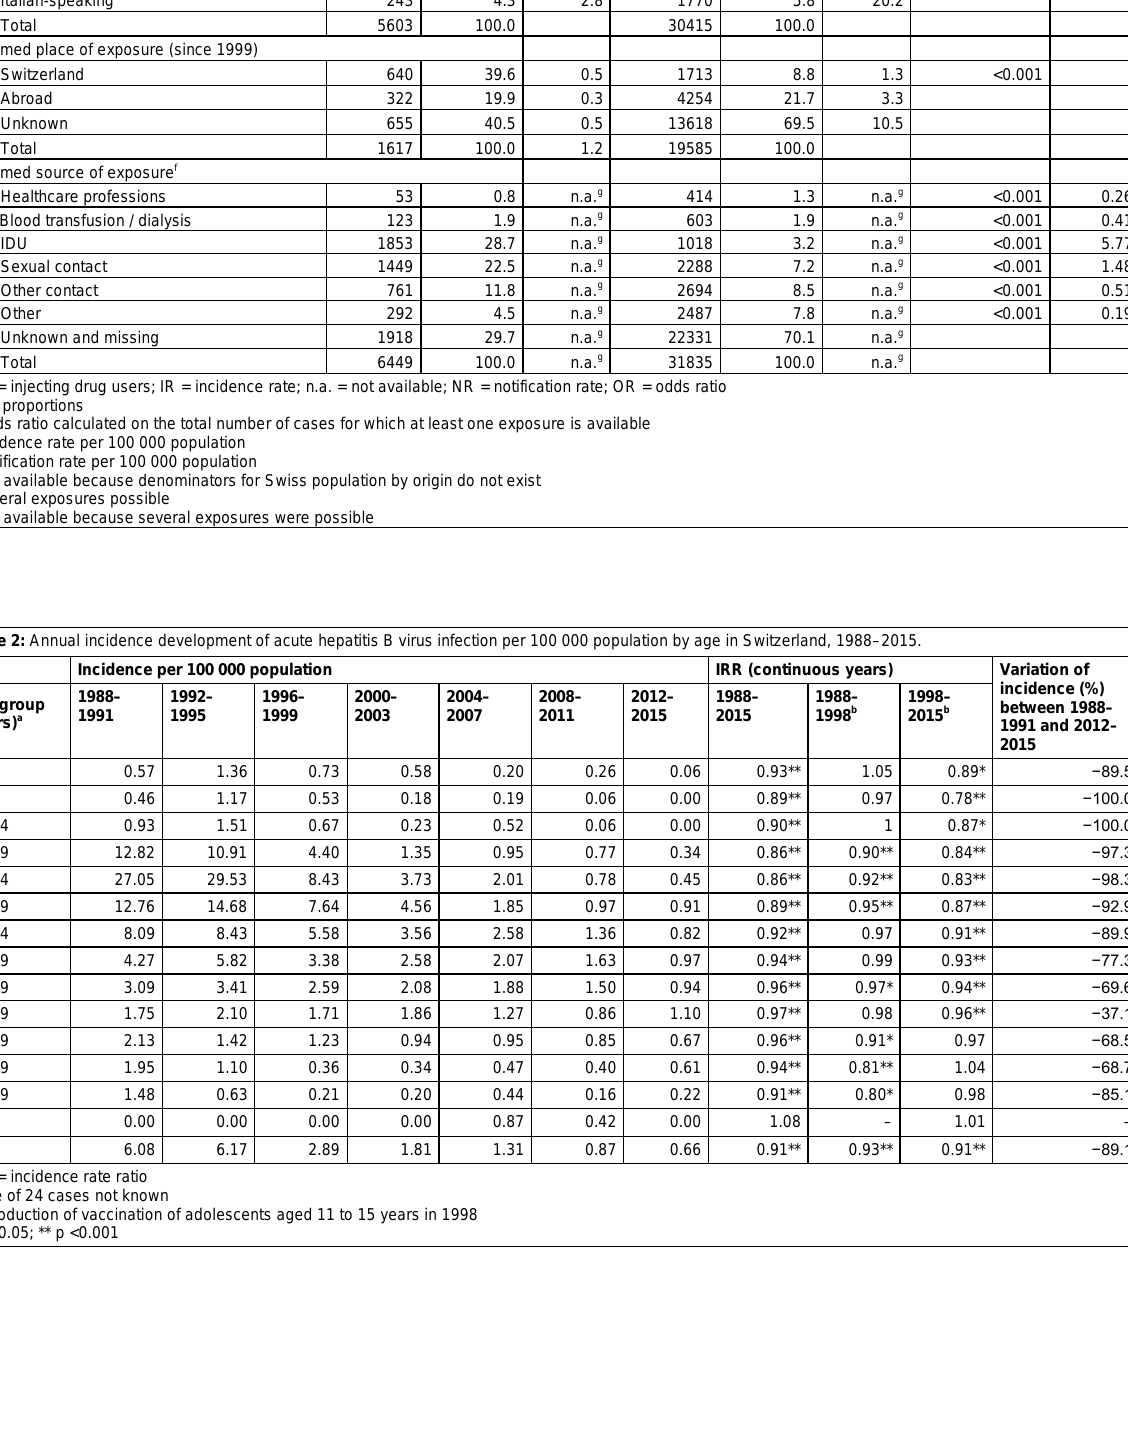
Table 1 (cont.) Region of Switzerland German-speaking